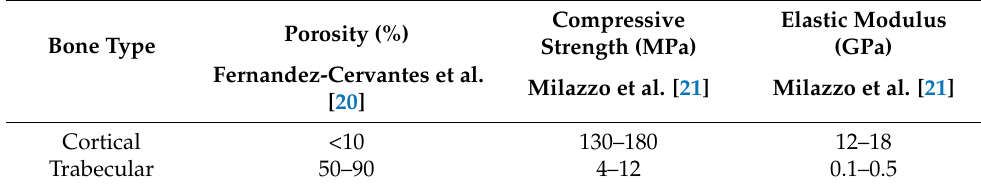
Table 1. Mechanical properties of cortical and trabecular